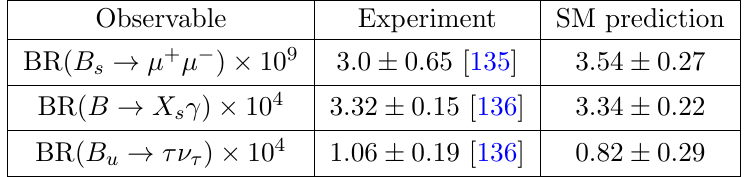
Table 5 . Experimental results and the corresponding SM values for the (cid:13)avour physics observables used in this work. The experimental data represents the most recent measurements or o(cid:14)cial